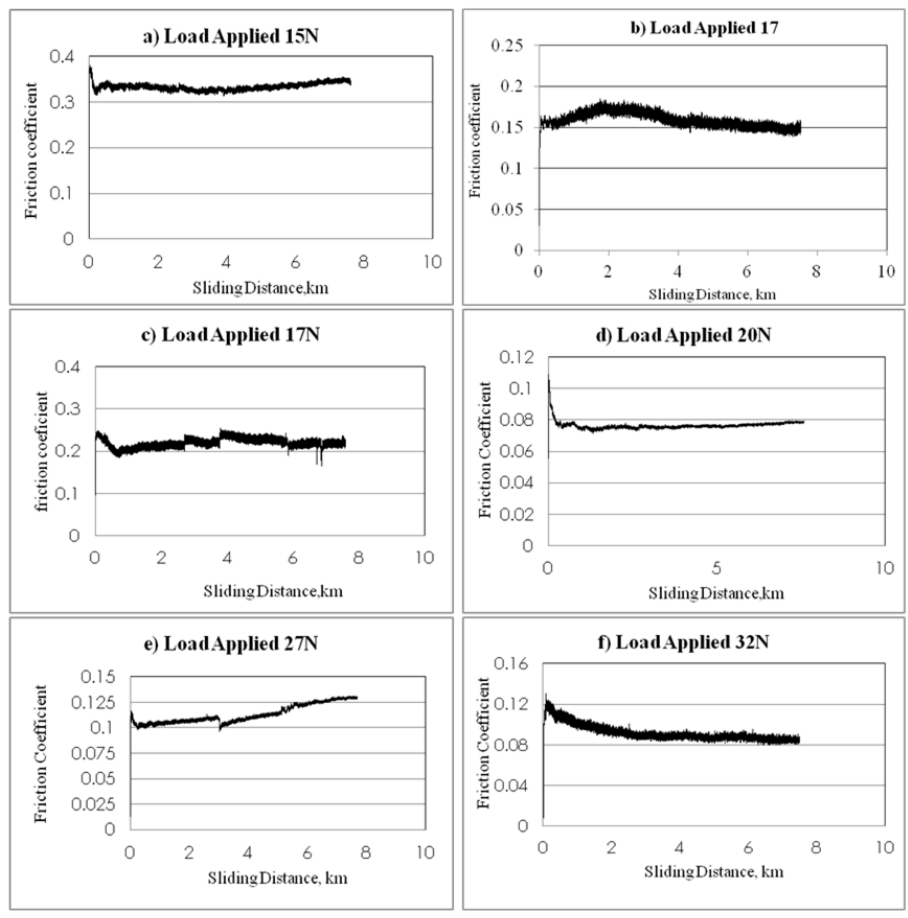
Figure 9. Frictional coefficient of bamboo fibre reinforced epoxy.